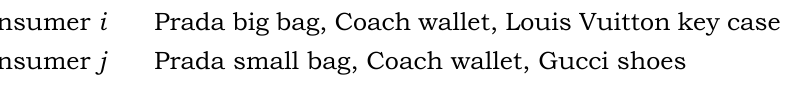
Table 1. Item possession (cohesion) They